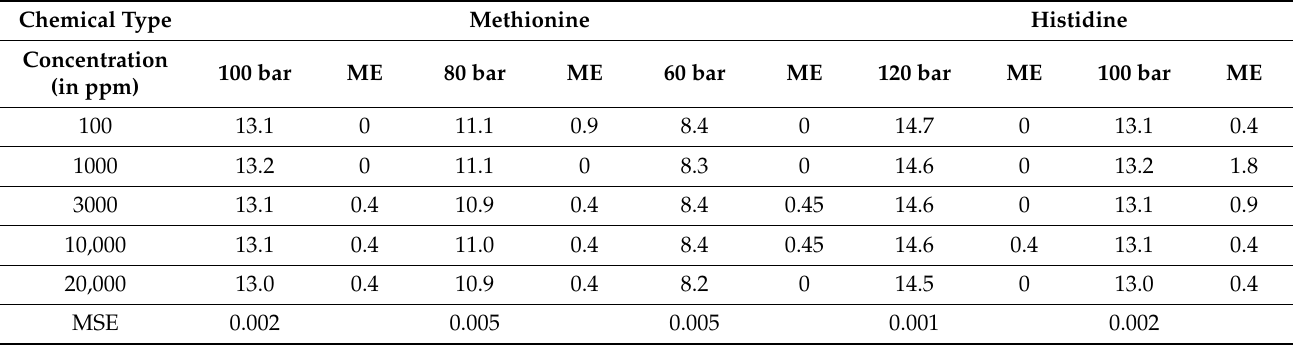
Table A4. Information about the dissociation temperature T d ( ◦ C) in the presence of L-methionine and L-histidine for different concentrations (100–20,000 ppm), ME is margin of error.